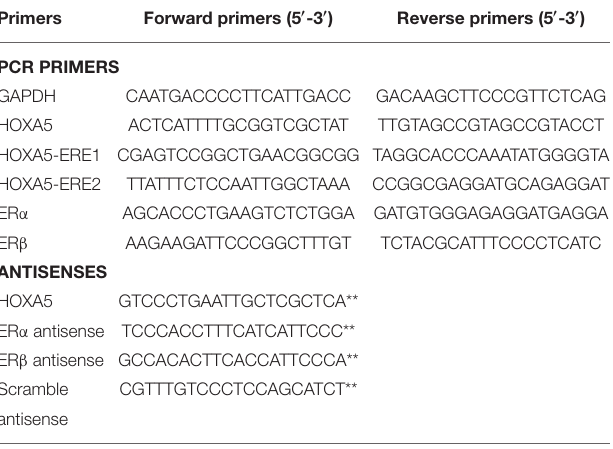
TABLE 1 | Primers used for cloning, RT-PCR, ChIP, and antisense experiments.